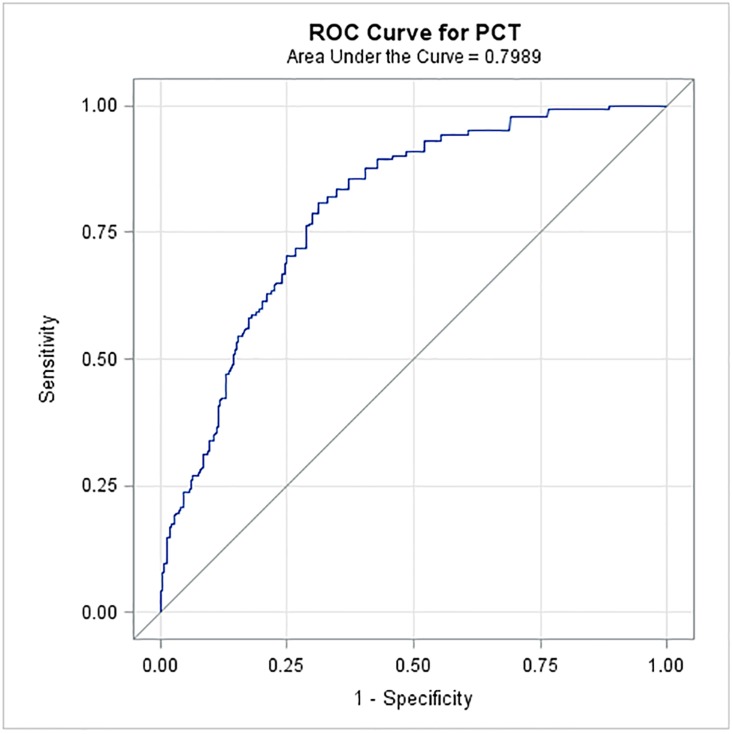
ROC curve of PCT test to differentiate febrile cancer patients with bacteremia or sepsis versus non-febrile cancer patients.